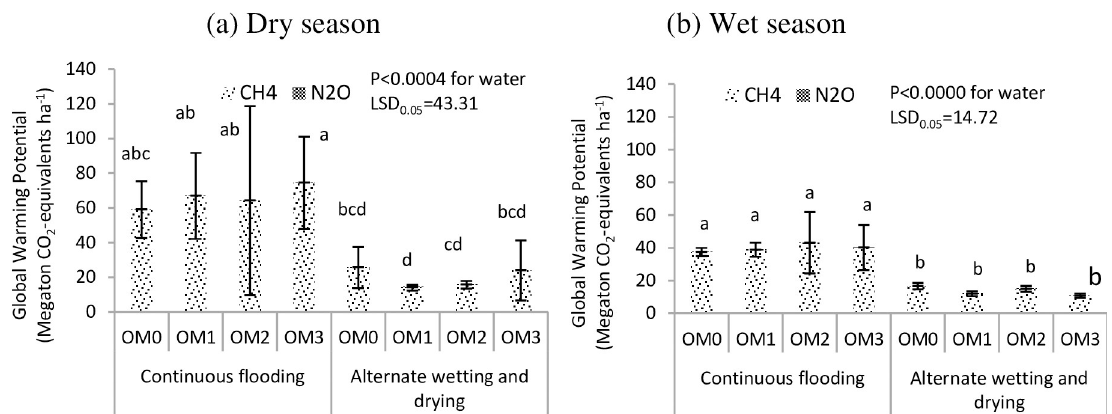
Fig 10. Effect of water and cow dung manure management on global warming potential of potted rice during dry (a) and wet (b) seasons, 2017. OM 0 -no cow dung, OM 1 - cow dung 2.5 t ha -1 , OM 2 - cow dung 5.0 t ha -1 , OM 3 - cow dung 7.5 t ha -1 . Mean value ± standard deviation (n = 3).